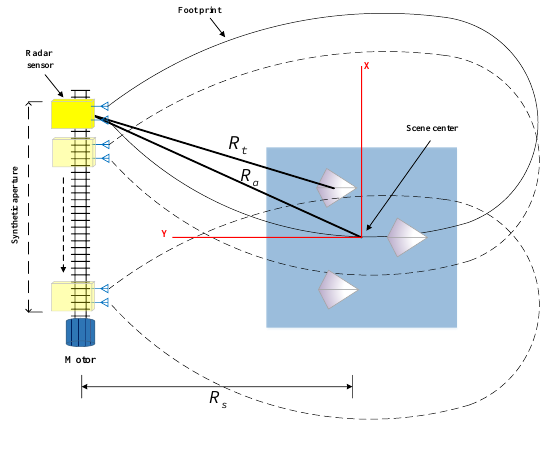
Figure 3. Rail-SAR imaging system The corresponding dechirped SAR signal phase, based on Figure 3. is (Carrara et al.,